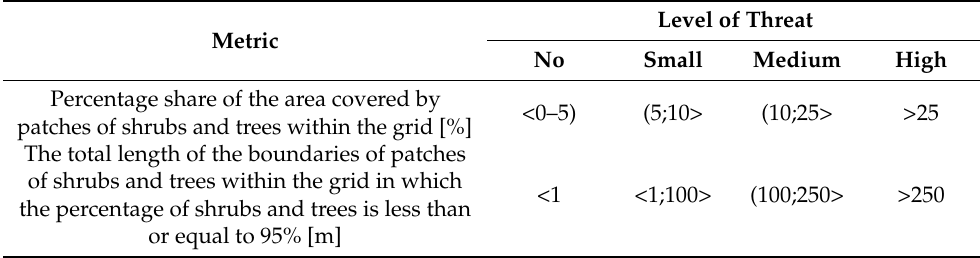
Table 3. The criteria used to define the levels of potential threat of succession for the whole analysed area.